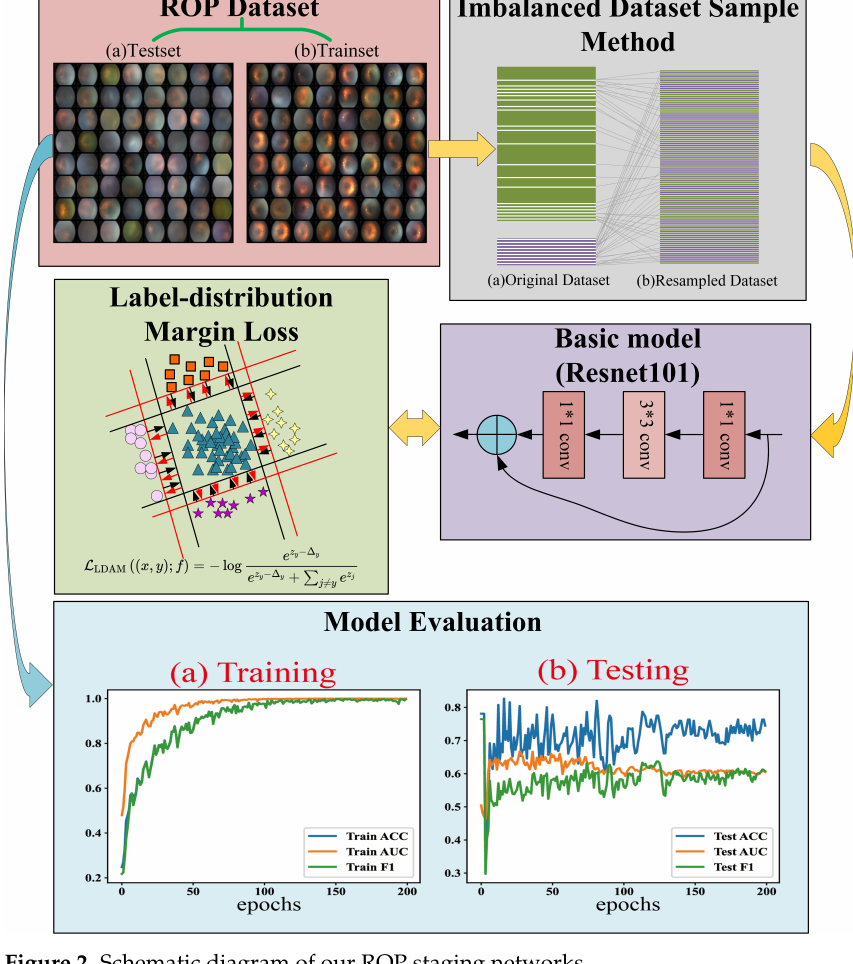
Figure 2. Schematic diagram of our ROP staging networks.